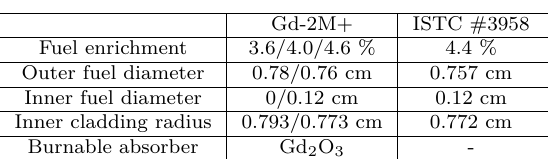
Table 1. Differences between Gd-2M+ and ISTC fuel